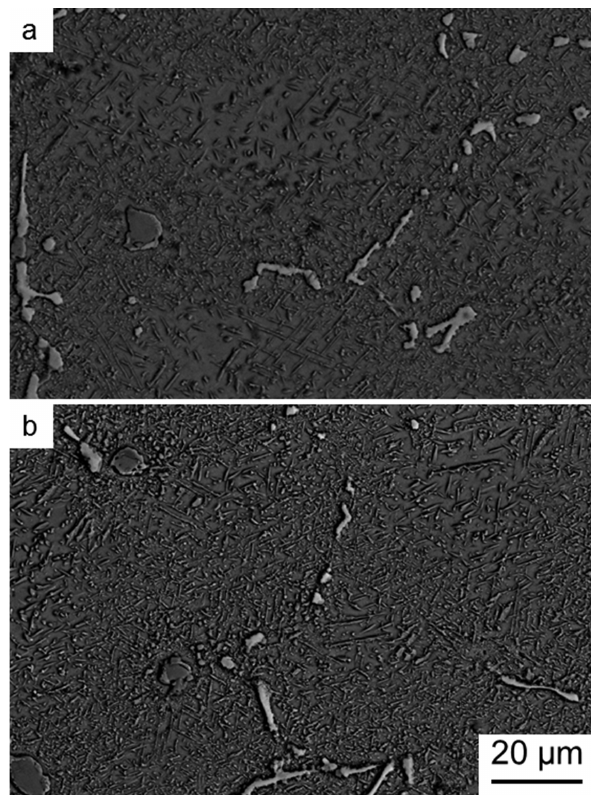
Figure 4: BE detector scanning electron micrographs of alloy aged for 500 (a) and 1000 h